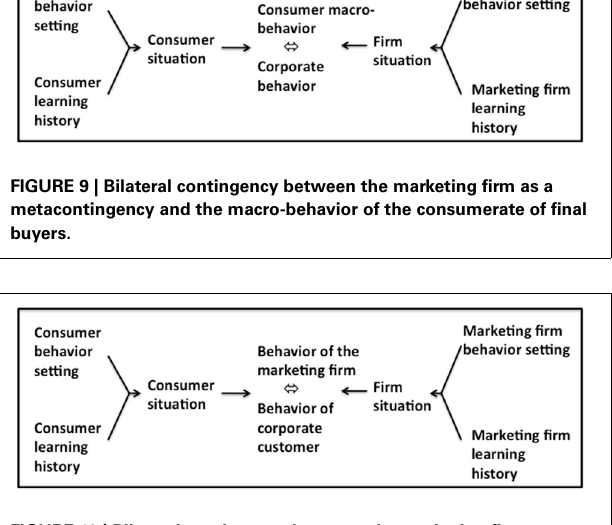
FIGURE 10 | Bilateral contingency between the marketing firm as a metacontingency and a corporate customer as a